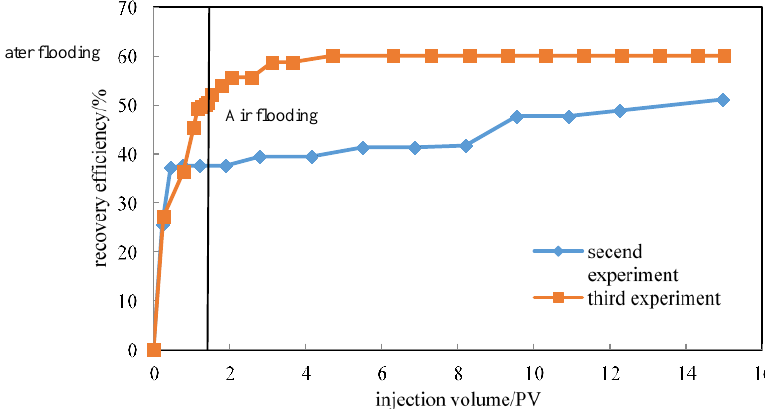
Figure 13. The second and the third group experiments of recovery ratio and multiple injection contrast analysis.